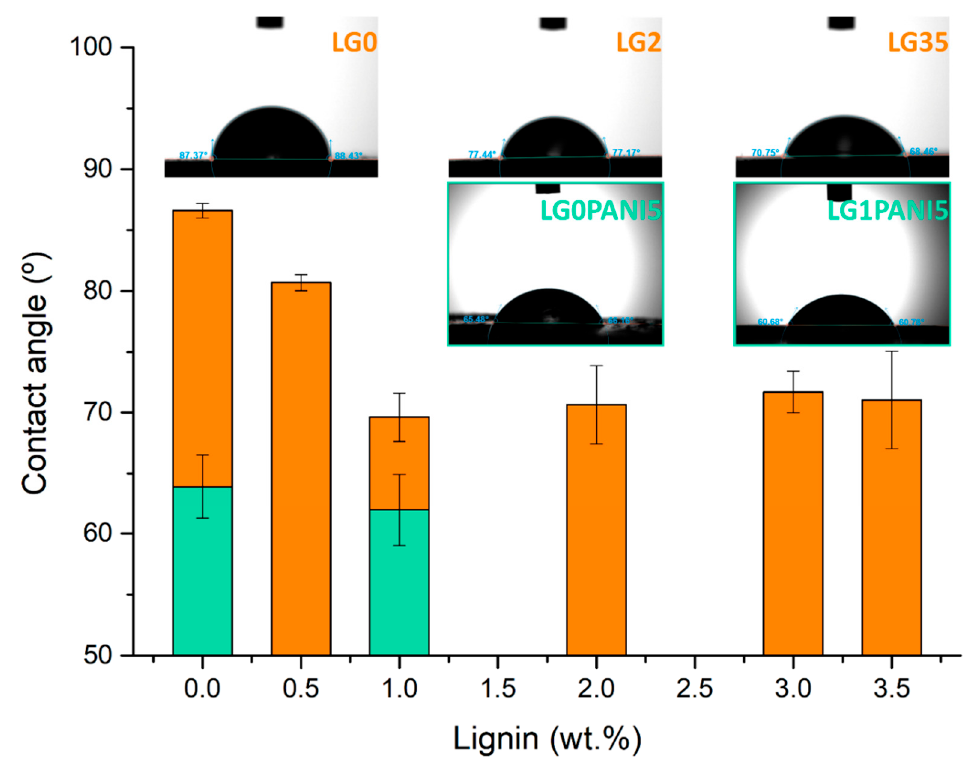
Figure 6. Water contact angle measurements on neat resin (L0), lignin composites of increasing lignin content (orange), and pTSA-PANIi composites (L0PANI5 and L1PANI5) (green).